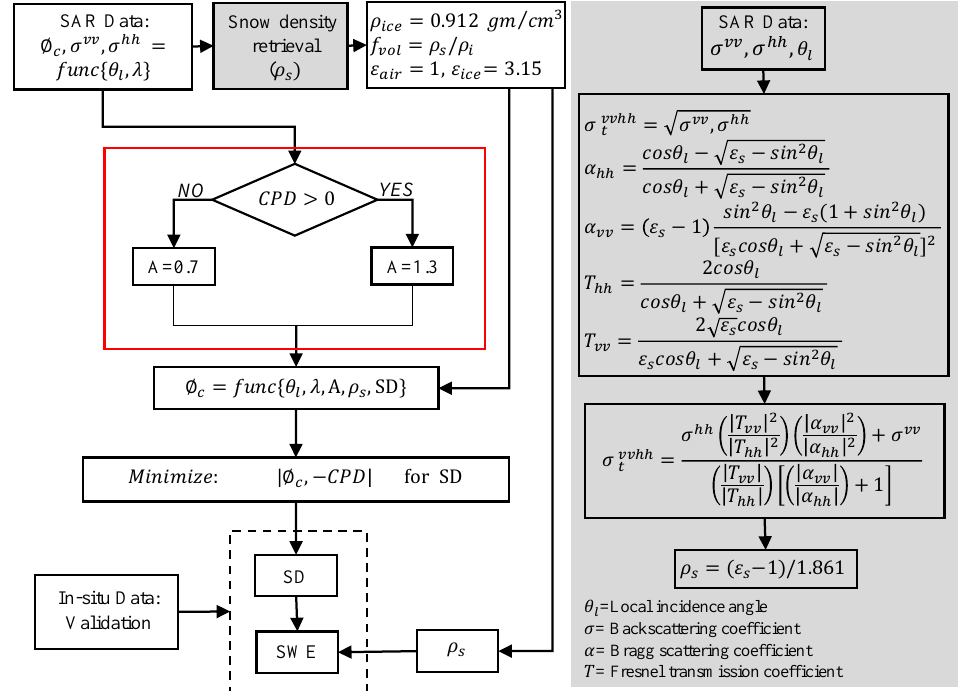
Figure 4. The snow depth (SD) and snow water equivalent (SWE) inversion using dual polarization (HH-VV) synthetic aperture radar (SAR) data. The snow density ( ρ s ) retrieval algorithm is highlighted in